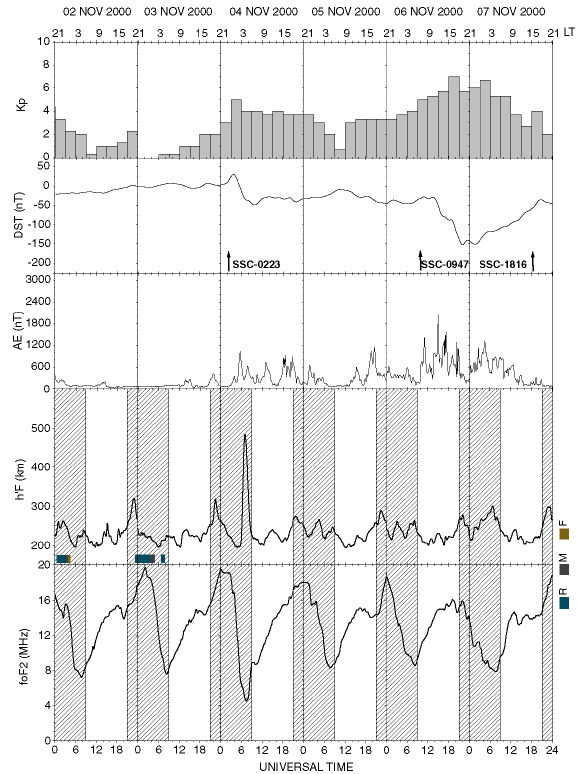
Fig. 4. Same as Fig. 2a, except for the period of 10 to 13 July 2003 and with the ionospheric parameters h 0 F and fo F2 observed at Palmas. The red arrows indicate the period when strong sporadic E at SJC did not permit scalings of the